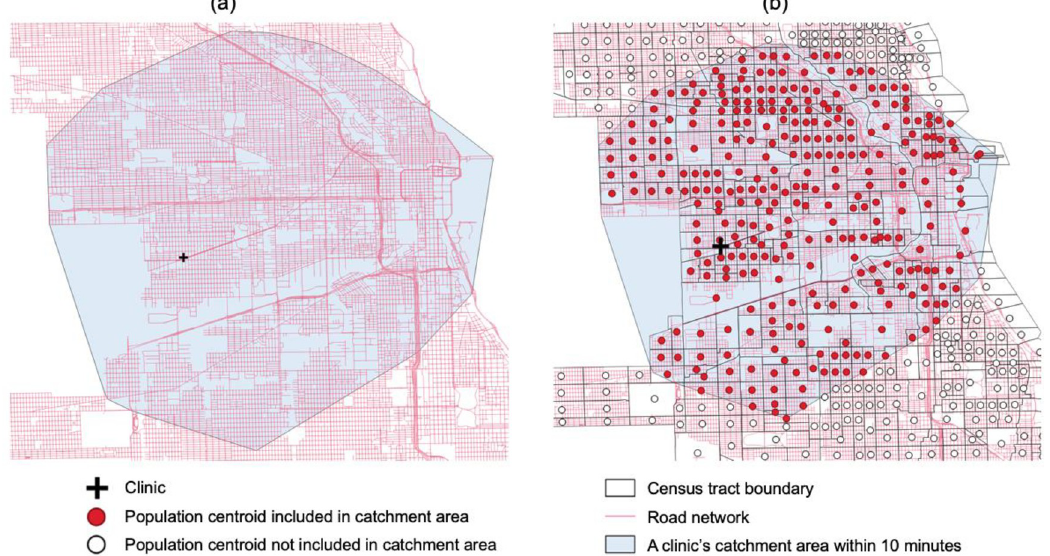
Fig 4. Delineate a clinic’s catchment area: (a) a clinic’s catchment area; (b) population centroids included in the catchment area.